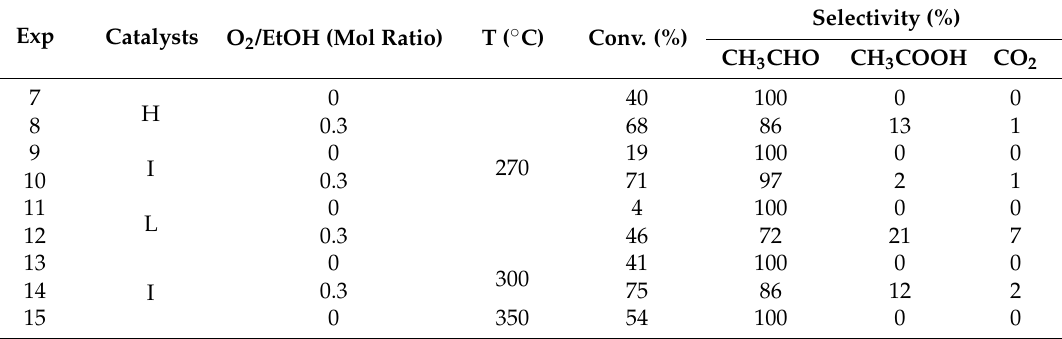
Table 3. Performance of cat H, I, and L (0.5% Au/silicalite-1 doped with CH 3 COOK. cat H = CH 3 COOK/Au = 10; cat I = CH 3 COOK/Au = 20, cat L = CH 3 COOK/Au = 50) in ethanol conversion.